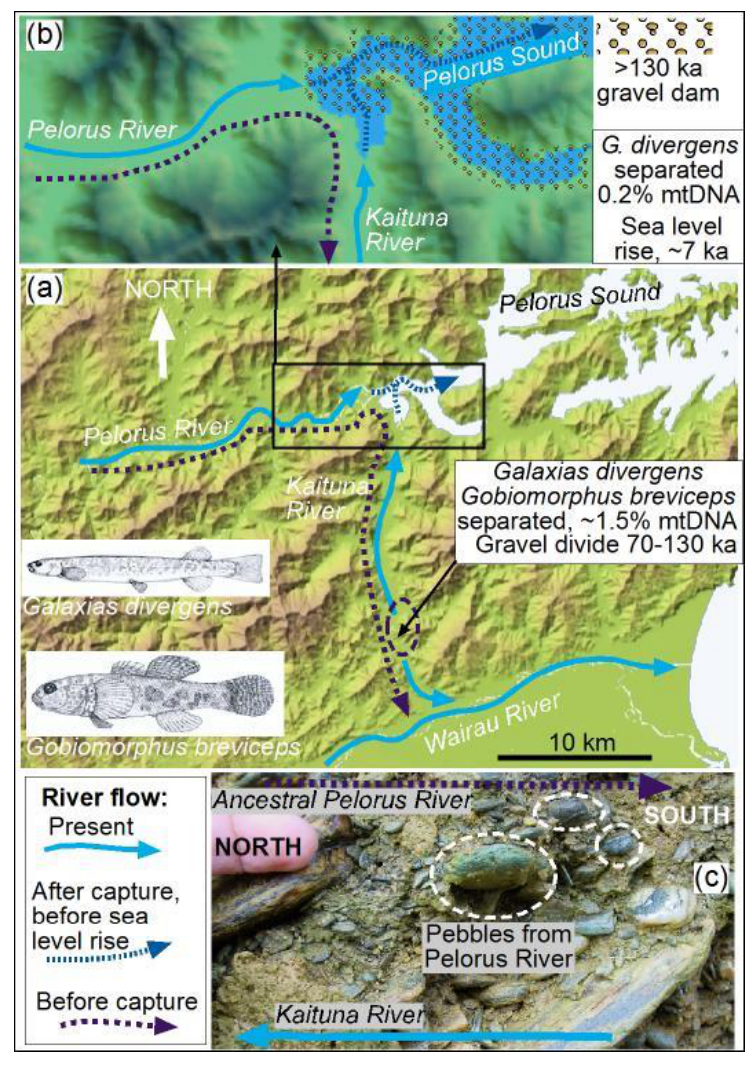
Figure 6. Mid-late Pleistocene glacial outwash from the Pelorus River (Marlborough Sounds) formed a gravel dam in what is now Pelorus Sound ( a , b ), a drowned river valley. This dam diverted the Pelorus River to the south ( a , b ) to transport distinctive pebbles towards the Wairau River ( c ) [41]. When the Pelorus Sound dam was breached in late Pleistocene, drainage reversal formed the north-flowing Kaituna River and separated Pelorus – Kaituna populations of Galaxias divergens from their Wairau River (Figure 1) relatives [16]. Holocene sea-level rise subsequently separated Kaituna River from Pelorus River, isolating their populations of G. divergens . Similar divergences are present in the co-distributed upland bully Gobiomorphus breviceps [16].